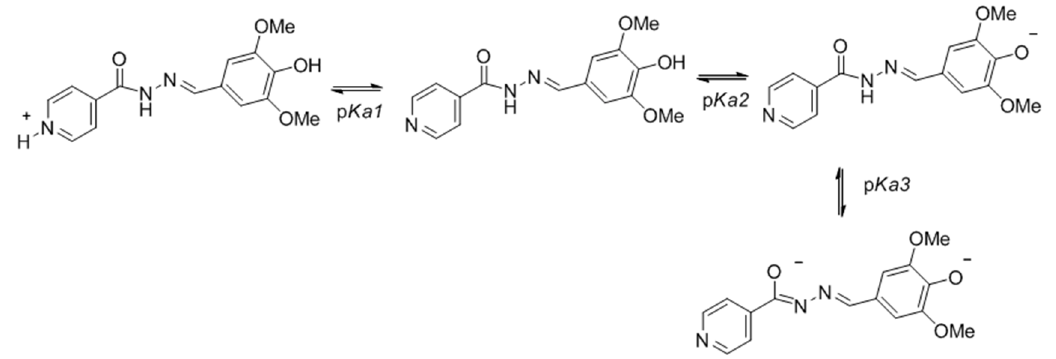
Figure 4. Protonation states of the hydrazone 1d as function of pH.